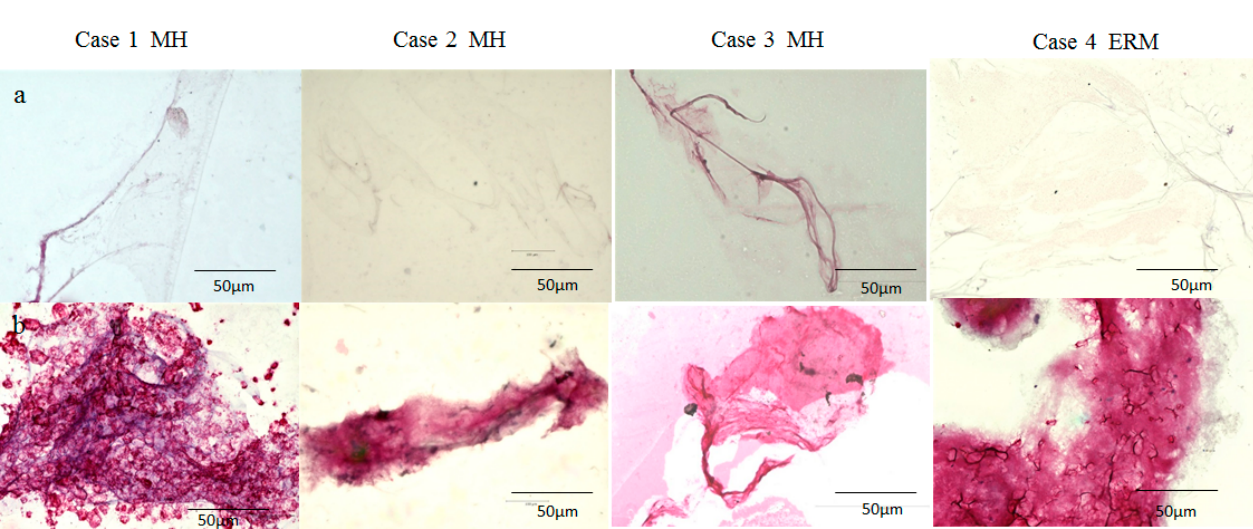
Figure 3. Immunostaining of the BPM specimen with antibodies for fibrillin-1. The vitreous core (VC) of patients with a macular hole (MH) and with an epiretinal membrane (ERM) was faintly stained with antibodies for fibrillin-1 ( a ), whereas the BPM was intensely stained ( b ).